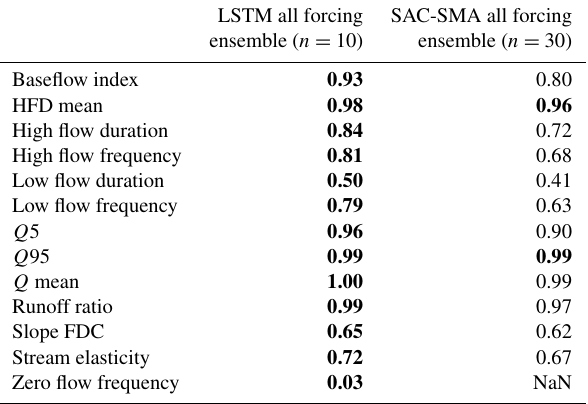
Table 3. Values of the correlation coefficients (over 531 basins) of the simulated vs. observed hydrological signatures from Table 1. Bold values indicate the best model ( α < 0 . 05). Multiple bold val- ues per row indicate no significant difference.